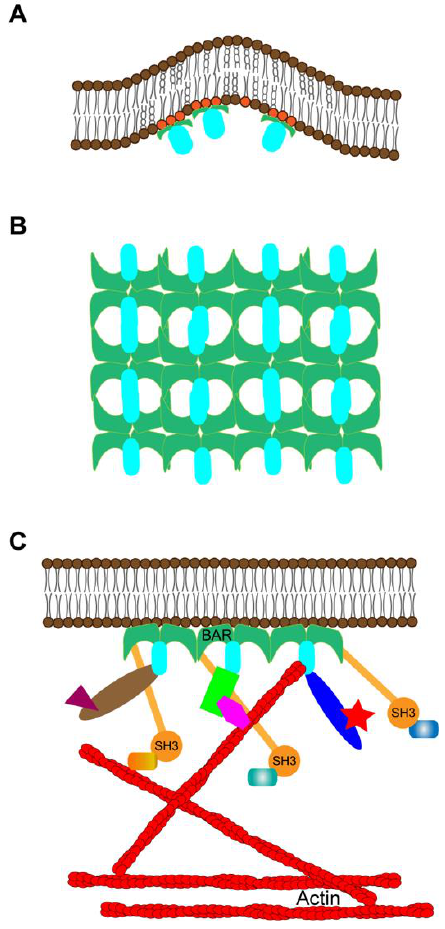
Figure 3. Possible mechanisms for BAR-domain protein involvement in spine initiation. ( A ) Some BAR-domain proteins bind to phosphoinositides on the plasma membrane, clustering lipids and curving the membrane. ( B ) Some BAR-domain proteins can form stable structures under the plasma membrane due to their intrinsic ability to self-assemble to form oligomers. ( C ) Some BAR domains can scaffold other proteins next to the plasma membrane, thus forming local signaling